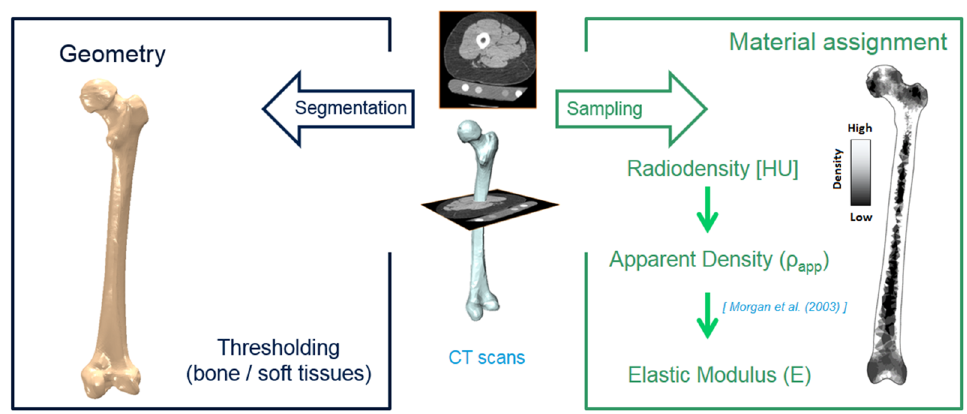
Fig 2. Femur model: Geometry and material properties